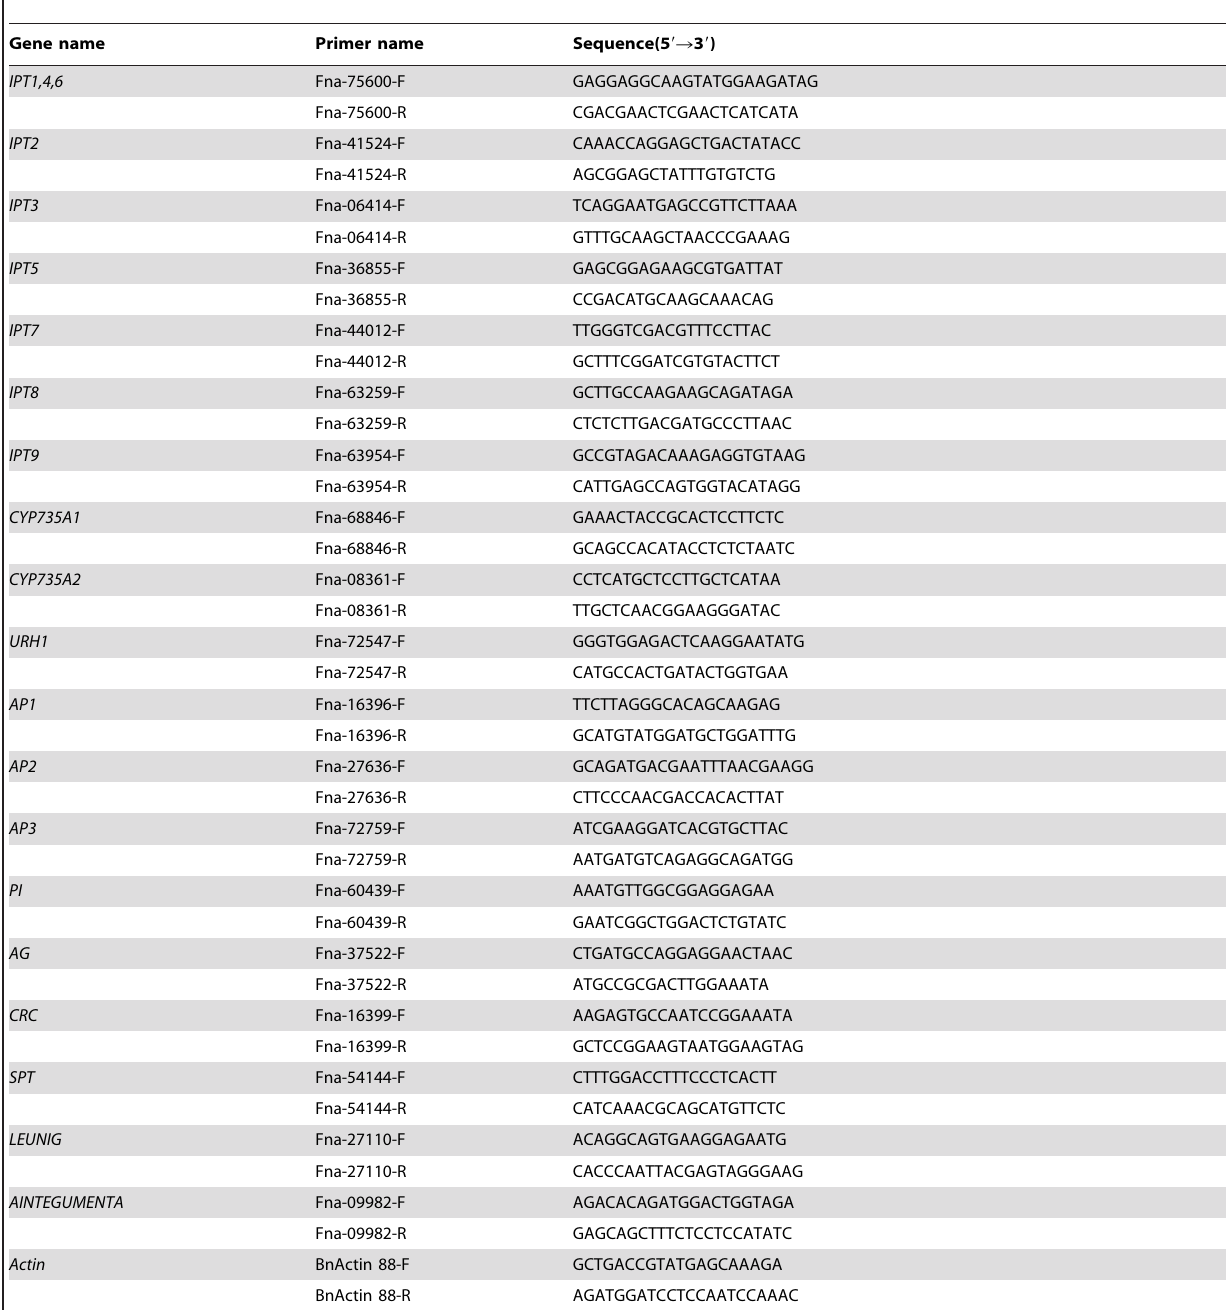
Table 1. Primers for real-time PCR checking genes related to cytokinin synthesis and flower